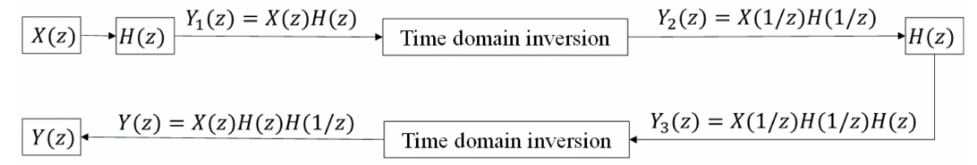
Figure 8. Schematic diagram of the